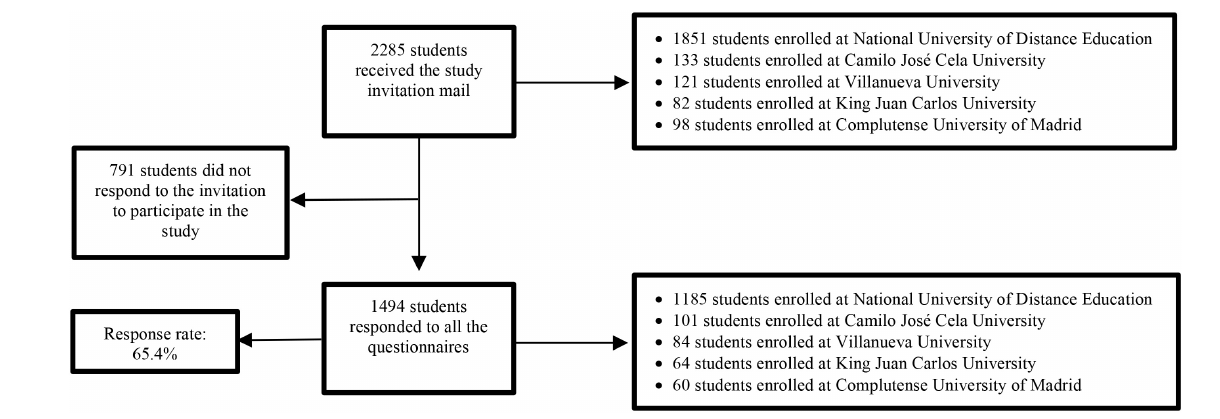
FIGURE 1 | Sampling